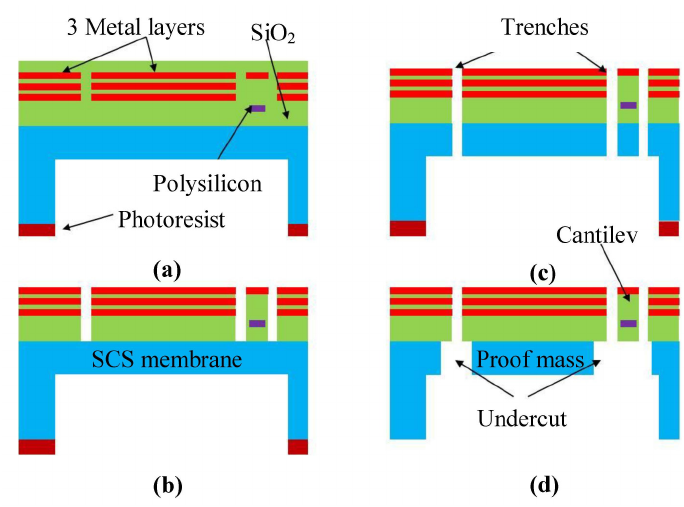
Figure 9. Post-CMOS microfabrication process